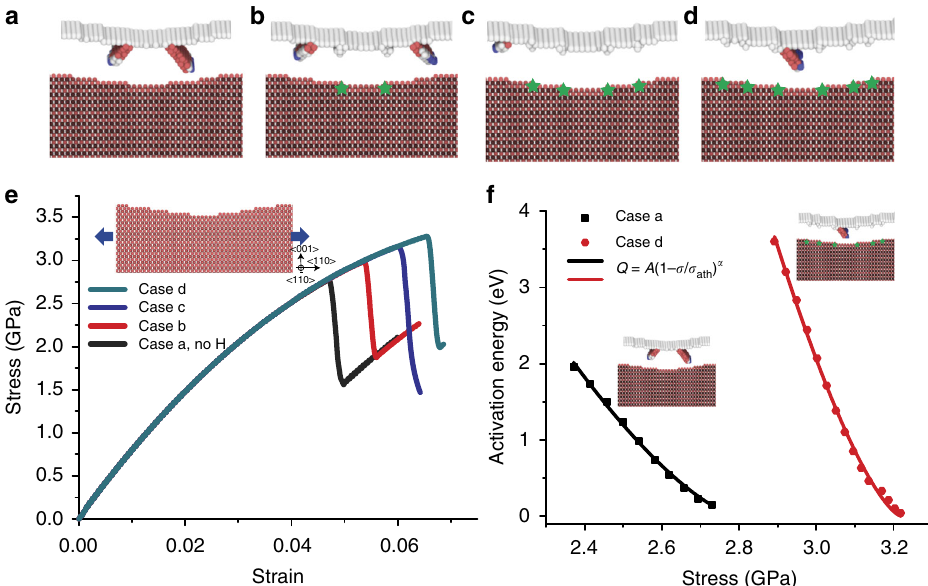
Fig. 4 MD simulations of dislocation nucleation. a – d Upper part of the fi gures shows dislocation nucleation sites. Green stars in the lower part of the fi gures indicate positions of hydrogen atoms. e Stress – strain curves corresponding to different con fi gurations in a to d . f Stress-dependent activation energy of dislocation nucleation. Black squares correspond to case a without hydrogen; red dots correspond to case d. Solid lines are fi tting